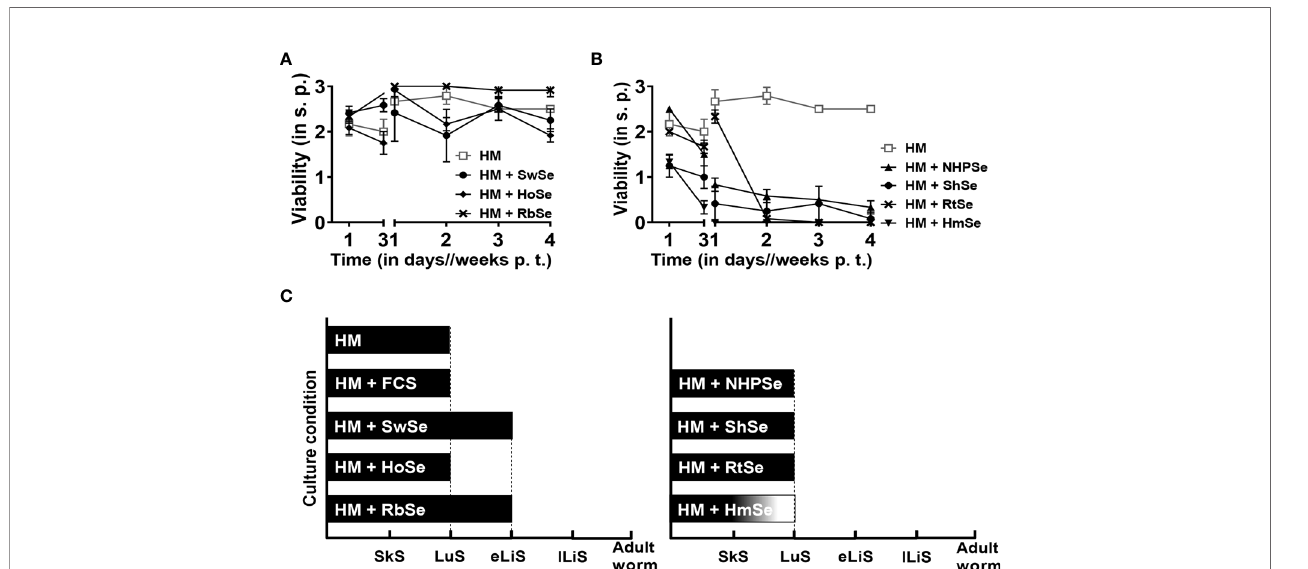
FIGURE 2 | Short- and long-term survival of NTS in serum is host speci fi c. NTS were cultured and maintained in hybridoma medium (HM) with or without 20% mammalian sera at 37°C in 5% CO 2 for four weeks. Medium supplemented with 20% of the corresponding serum was refreshed weekly. (A) Serum effects of mammalian species which ensured long-term survival of NTS. NTS were cultured in the absence (HM) or presence of 20% serum from swine (SwSe), horses (HoSe) or rabbits (RbSe) and viability was scored. All sera ensured survival of NTS for at least four weeks after transformation. (B) Serum effects of mammalian species that heavily impaired viability of NTS. NTS were cultured in the absence or presence of 20% serum from rhesus macaques (NHPSe), sheep (ShSe), rats (RtSe) or hamsters (HmSe) and viability was scored. Results are representative of at least three individual experiments. Each data point has been shown as mean ± SD of at least three technical replicates. (C) Schematic representation of stage-dependent development of schistosomula. NTS were cultured with sera of indicated species in the same manner as above and monitored microscopically. SkS, skin stage. LuS, lung stage. eLiS, early liver stage. lLiS, late liver stage. p.t., post transformation. s.p., scoring